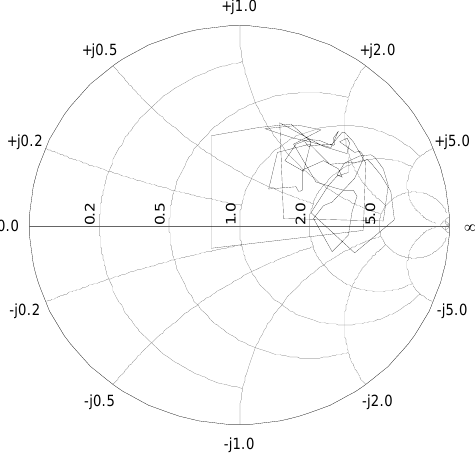
complex data used in the experimental training 11